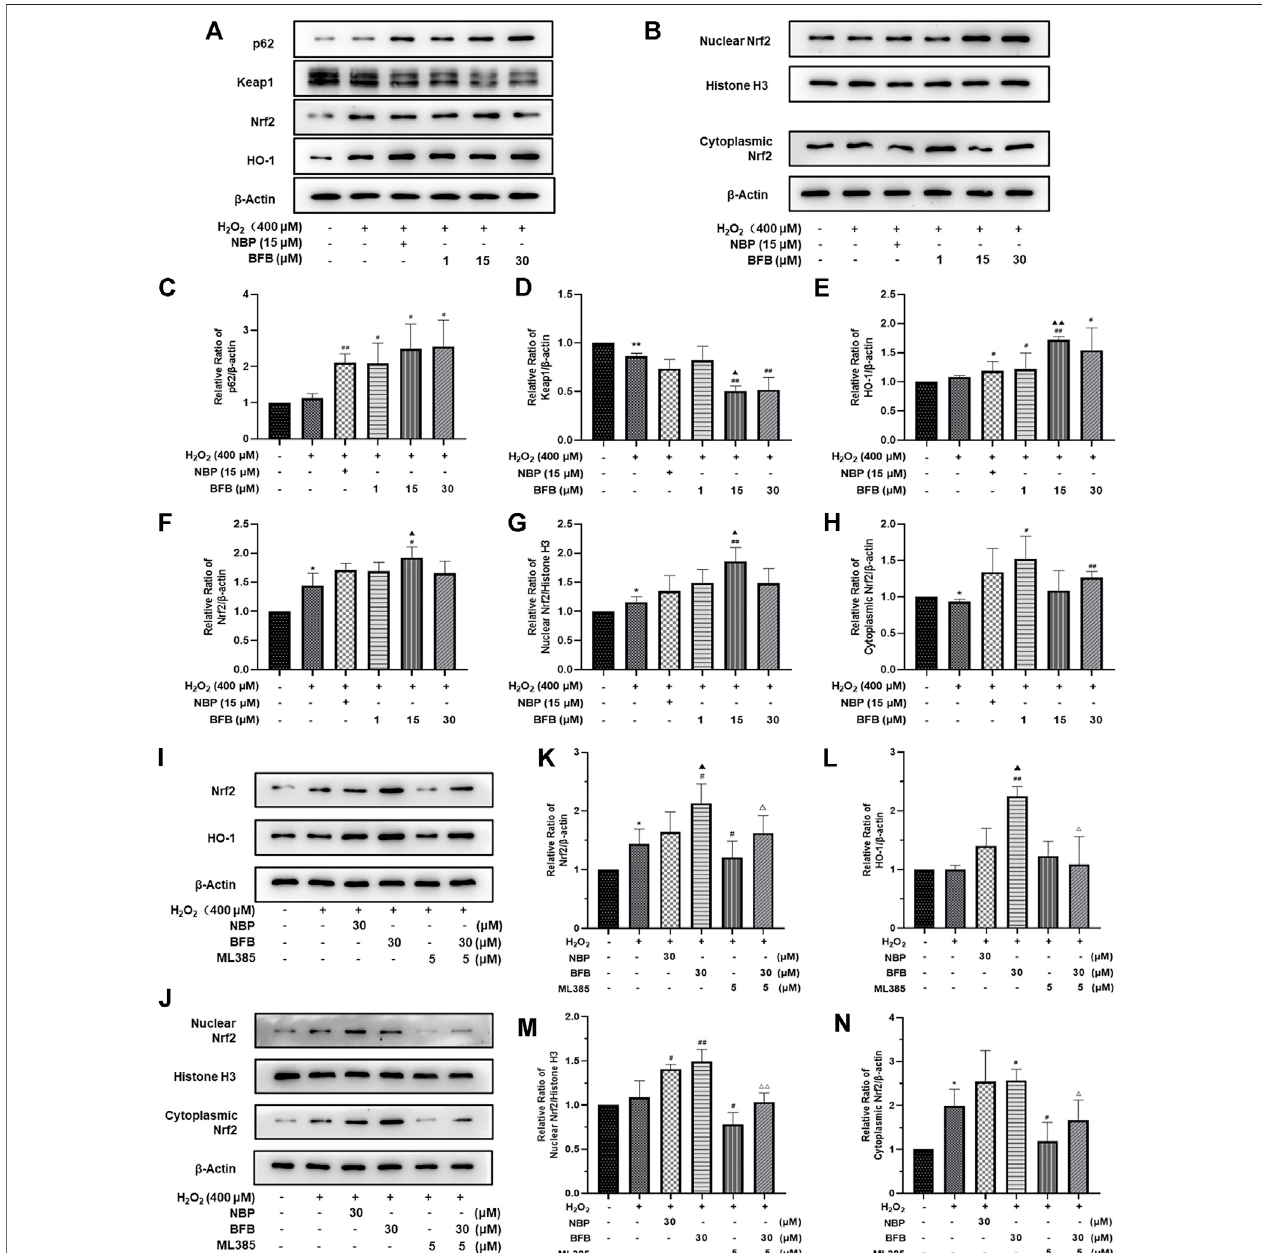
FIGURE 5 | BFB ’ s role in cellular P62-Keap1-Nrf2 pathway-related factors protein expression level. 400 μ M H 2 O 2 treatment in PC12 cells with/without BFB (1, 5, 10 μ m)orNBP(15 μ m)fora3-hperiod (A) p62,keap1,HO-1andtotalNrf2proteinlevelswereexaminedbyWB (B) NuclearandcytoplasmicNrf2proteinfractionswere analyzed through WB (C – H) Quanti fi cation of relative band intensities of p62, keap1, total Nrf2, HO-1, nuclear Nrf2 and cytoplasmic Nrf2, and β -actin or Histone H3 served as loading control. Nrf2 suppression mitigated BFB ’ s inhibition on oxidative stress. 5 μ m ML385 was added to pretreat PC12 cells for a 0.5-h period, followed by stimulation using H 2 O 2 (400 μ m) with/without BFB (30 μ m) or NBP (30 μ m) (I) Total Nrf2 and HO-1 protein expression determined through WB assay (J) NuclearandcytoplasmicNrf2proteindeterminedbyWesternBlot (K – N) Quanti fi cationofrelativebandintensitiesoftotalNrf2,HO-1,nuclearNrf2andcytoplasmicNrf2, with β -actin or Histone H3 being the endogenous reference. The values were represented by mean ± SD from 3 separate assays. * p < 0.05, ** p < 0.01, versus Control, ▲ p < 0.05, ▲▲ p < 0.01, versus NBP group. △ p < 0.05, △△ p < 0.01, versus ML385 group. # p < 0.05, ## p < 0.01, versus H 2 O 2 group.